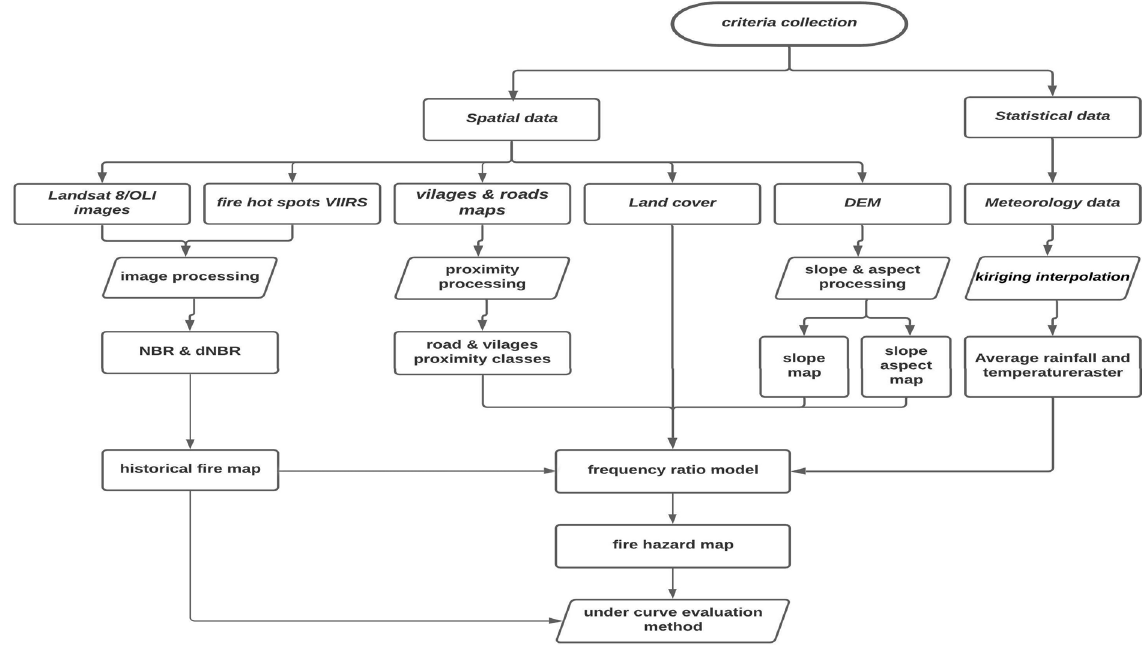
Figure 3. Flowchart of used methodology in fire hazard